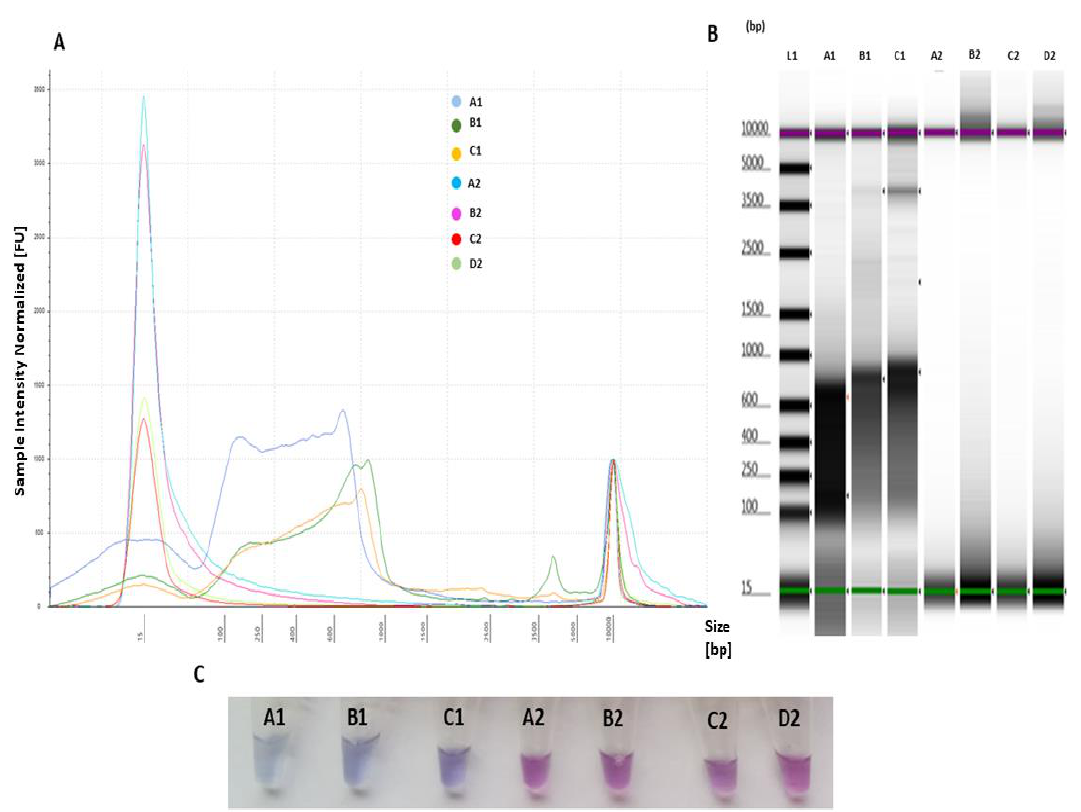
Figure 4. LAMP primer evaluation for specific target amplification and applicability to detect OsHV-1 present in the sample through comparison of positive and negative templates: A1—L_1 (10 3 copies virus/reaction), B1—OsHV-1 plasmid (10 5 copies virus/reaction), C1—L_3 (10 3 copies virus/reaction), A2—NTC, B2—nuclease-free water (negative control), C2—UN_1 containing other DNA than the target (negative control) and D2—AbHV plasmid (negative control). ( A ) Electropherogram